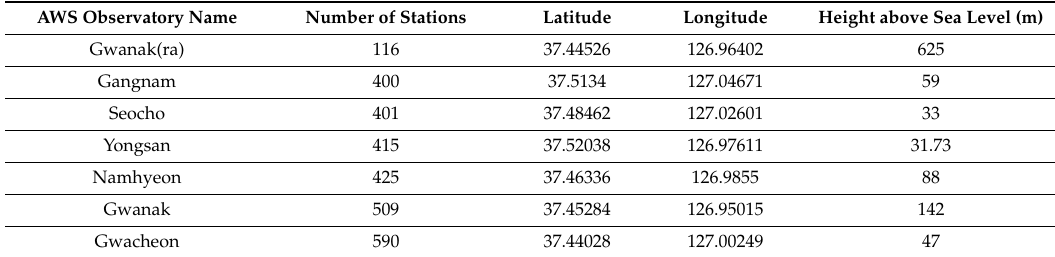
Table 3. Automatic weather system (AWS) observatory information .